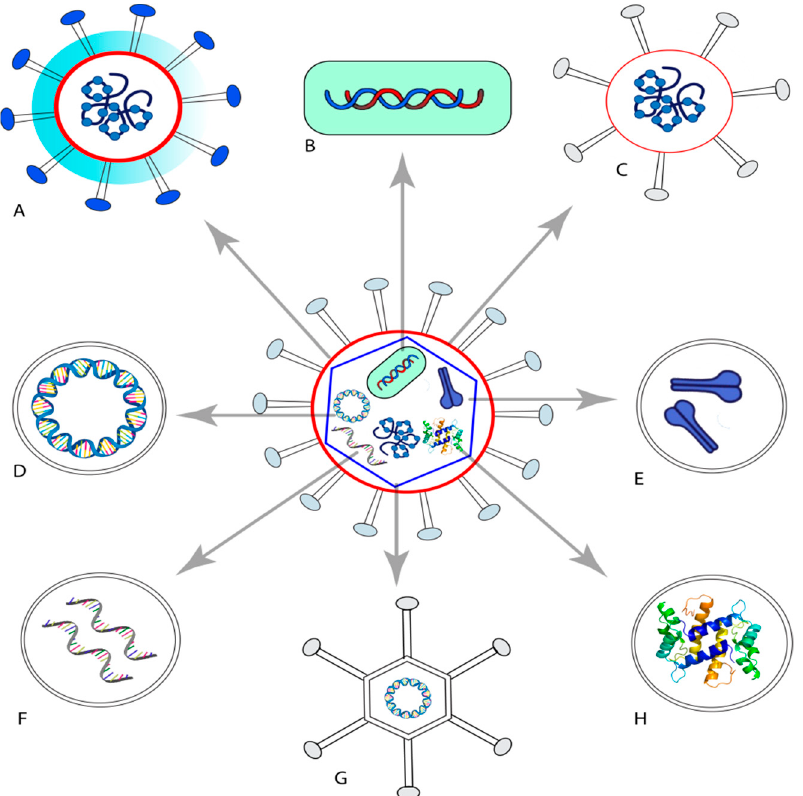
Figure 1. Summary of the different strategies used for vaccine development. ( A ) Live attenuated vaccine. ( B ) Genetically improved live vaccine (bacterial vector). ( C ) Inactivated nonliving vaccine. ( D ) Nucleic acid-based vaccine (DNA). ( E ) Genetically improved protein subunit. ( F ) Nucleic acid-based vaccine (RNA). ( G ) Genetically improved live vaccine (viral vector). ( H ) Synthetic peptide-based vaccine.